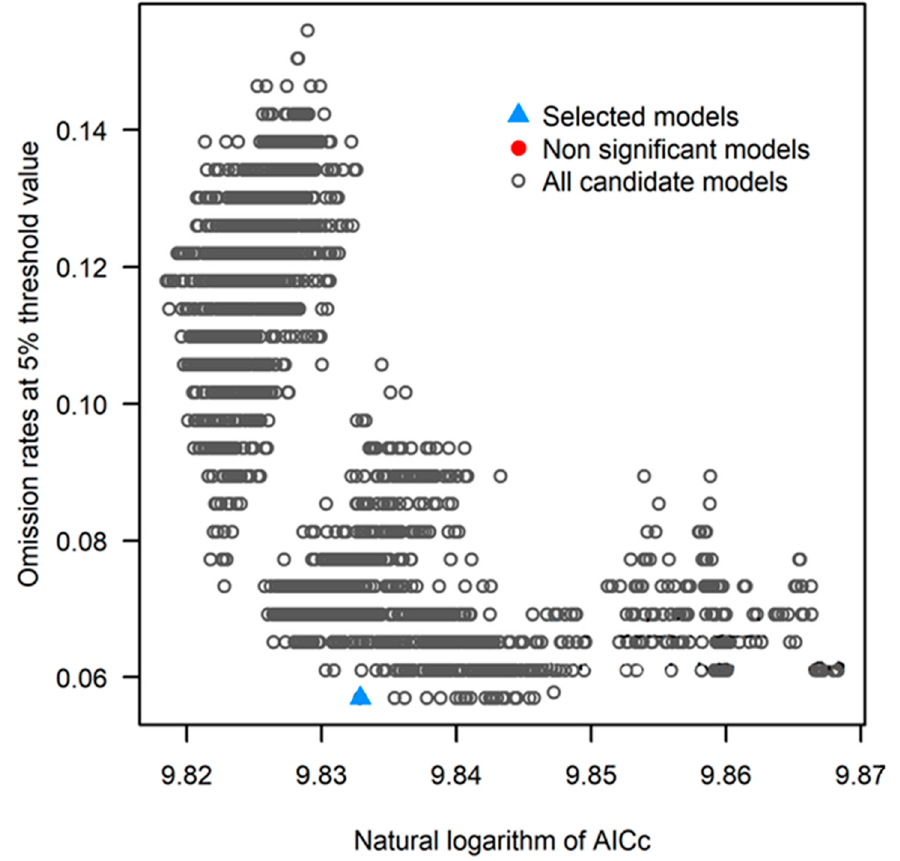
Figure 2. Omission rates at 5% and AICc values for all, non-significant, and selected ‘best’ candidate models for coconut. Models were selected based on statistical significance, omission rates, and AICc values.